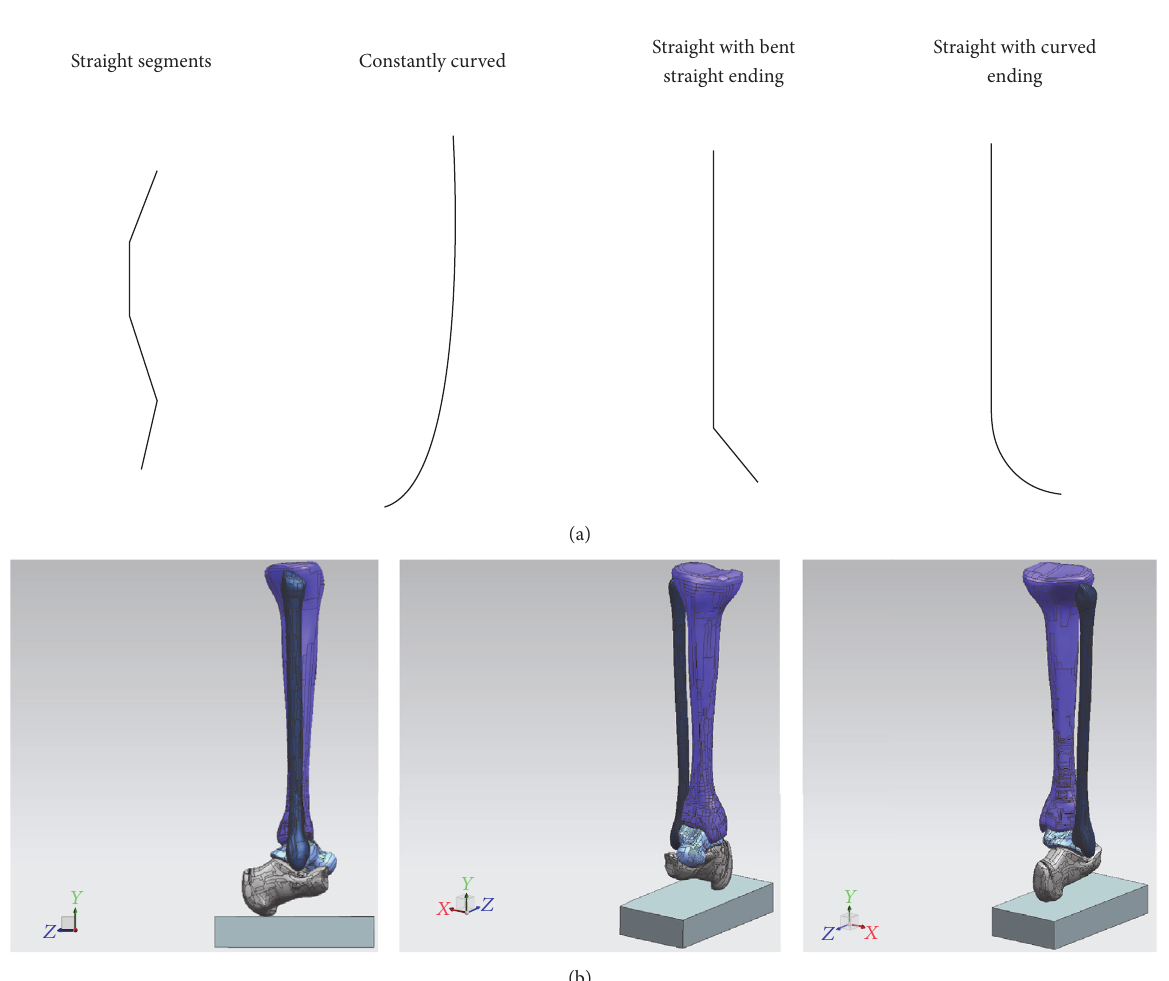
Figure 4: (a) Basic structure geometries. (b) CAD